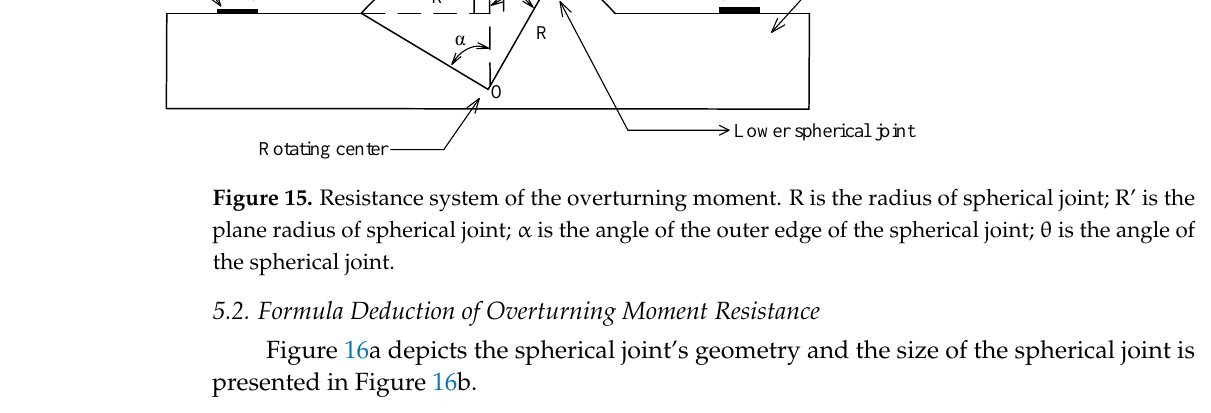
plane radius of spherical joint; α is the angle of the outer edge of the spherical joint; θ is the angle of